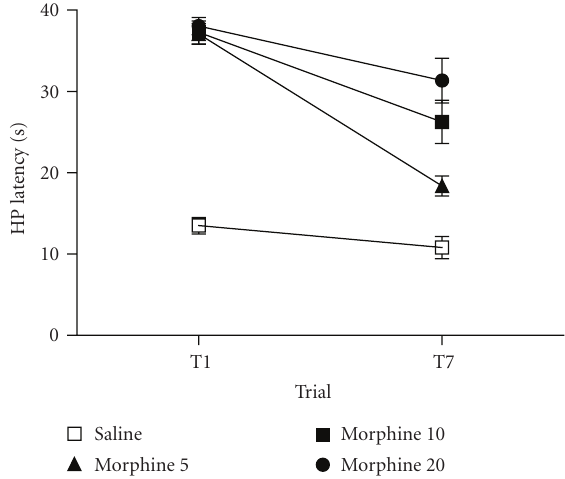
Figure 1: Tolerance to antinociception develops with repeated injections of morphine. The hot-plate latency following morphine administration on trial 7 was significantly less than on trial 1 for the morphine-treated groups (F(1, 39) = 31.38, P < .01). Antinociception was still evident with the administration of large doses of morphine (10 and 20 mg/kg), but not as pronounced as on trial 1. Large sample sizes were used for most groups ( N = 19, 5, 19, and 17 for rats pretreated with saline and morphine at 5, 10, and 20mg/kg, resp.) because subsets of these rats were subsequently tested using either the formalin test or repeated hot-plate tests.